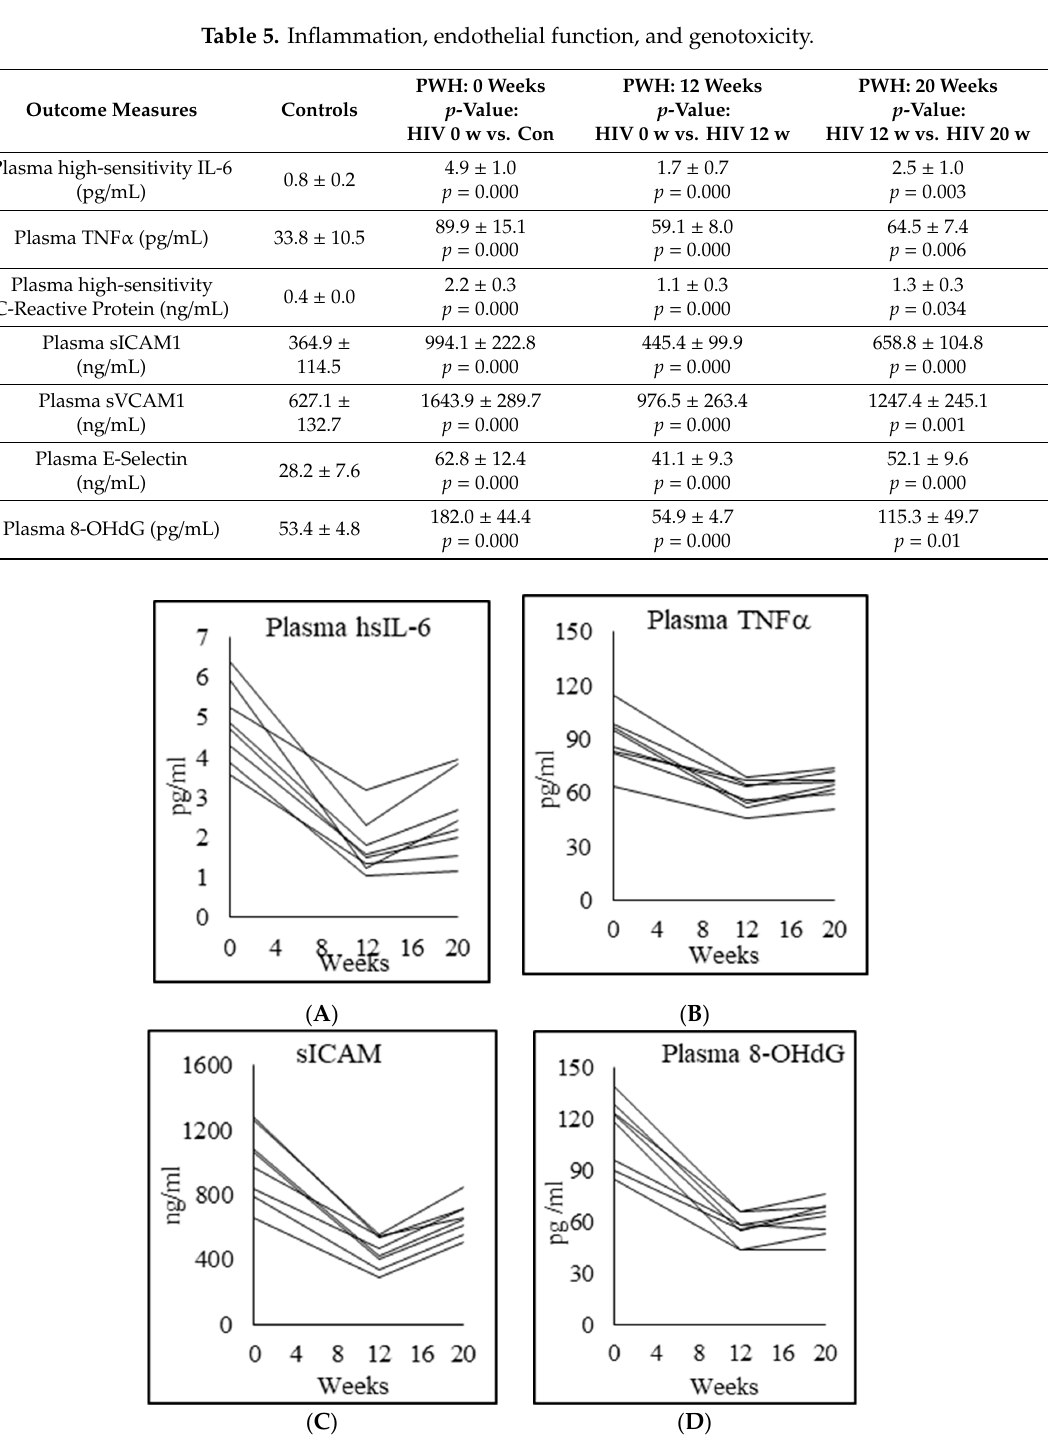
Figure 4. Individual participant data showing plasma concentrations of ( A ) interleukin 6 (IL-6); ( B ) tumor-necrosis factor alpha (TNF α ); ( C ) soluble intercellular adhesion molecule 1 (sICAM1); and ( D ) 8-hydroxy-2-deoxyguanosine (8-OHdG) concentrations.